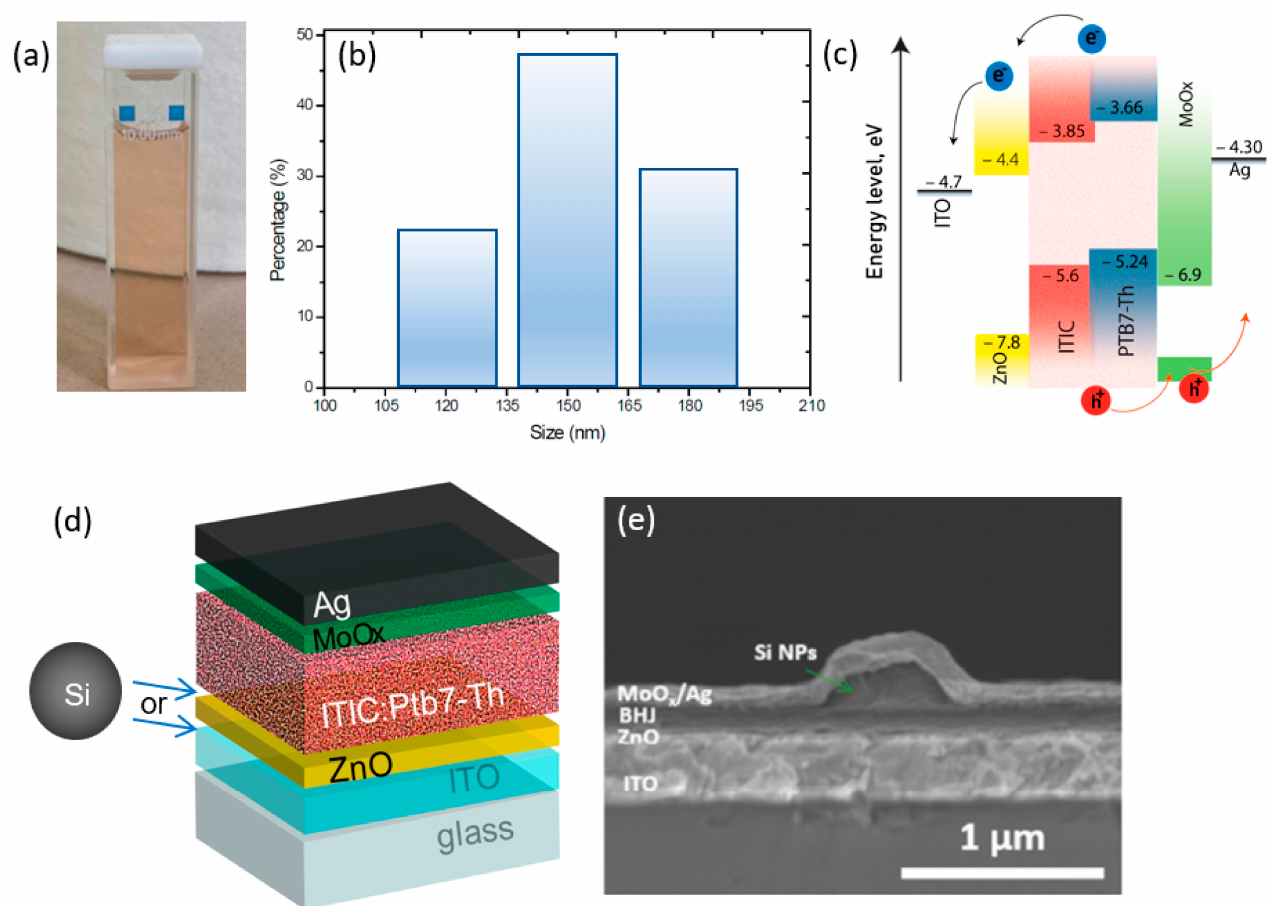
Figure 1. ( a ) Photo of a colloidal solution of Si NPs in isopropanol. ( b ) Size distribution of Si NPs in the solution. ( c ) Energy band diagram of the device. ( d ) Schematic illustration of the architecture of the studied organic solar cells. Arrows indicate the two positions of Si NPs deposition. ( e ) Cross-sectional SEM image of the obtained device with a single Si NP covered by BHJ/MoO x /Ag